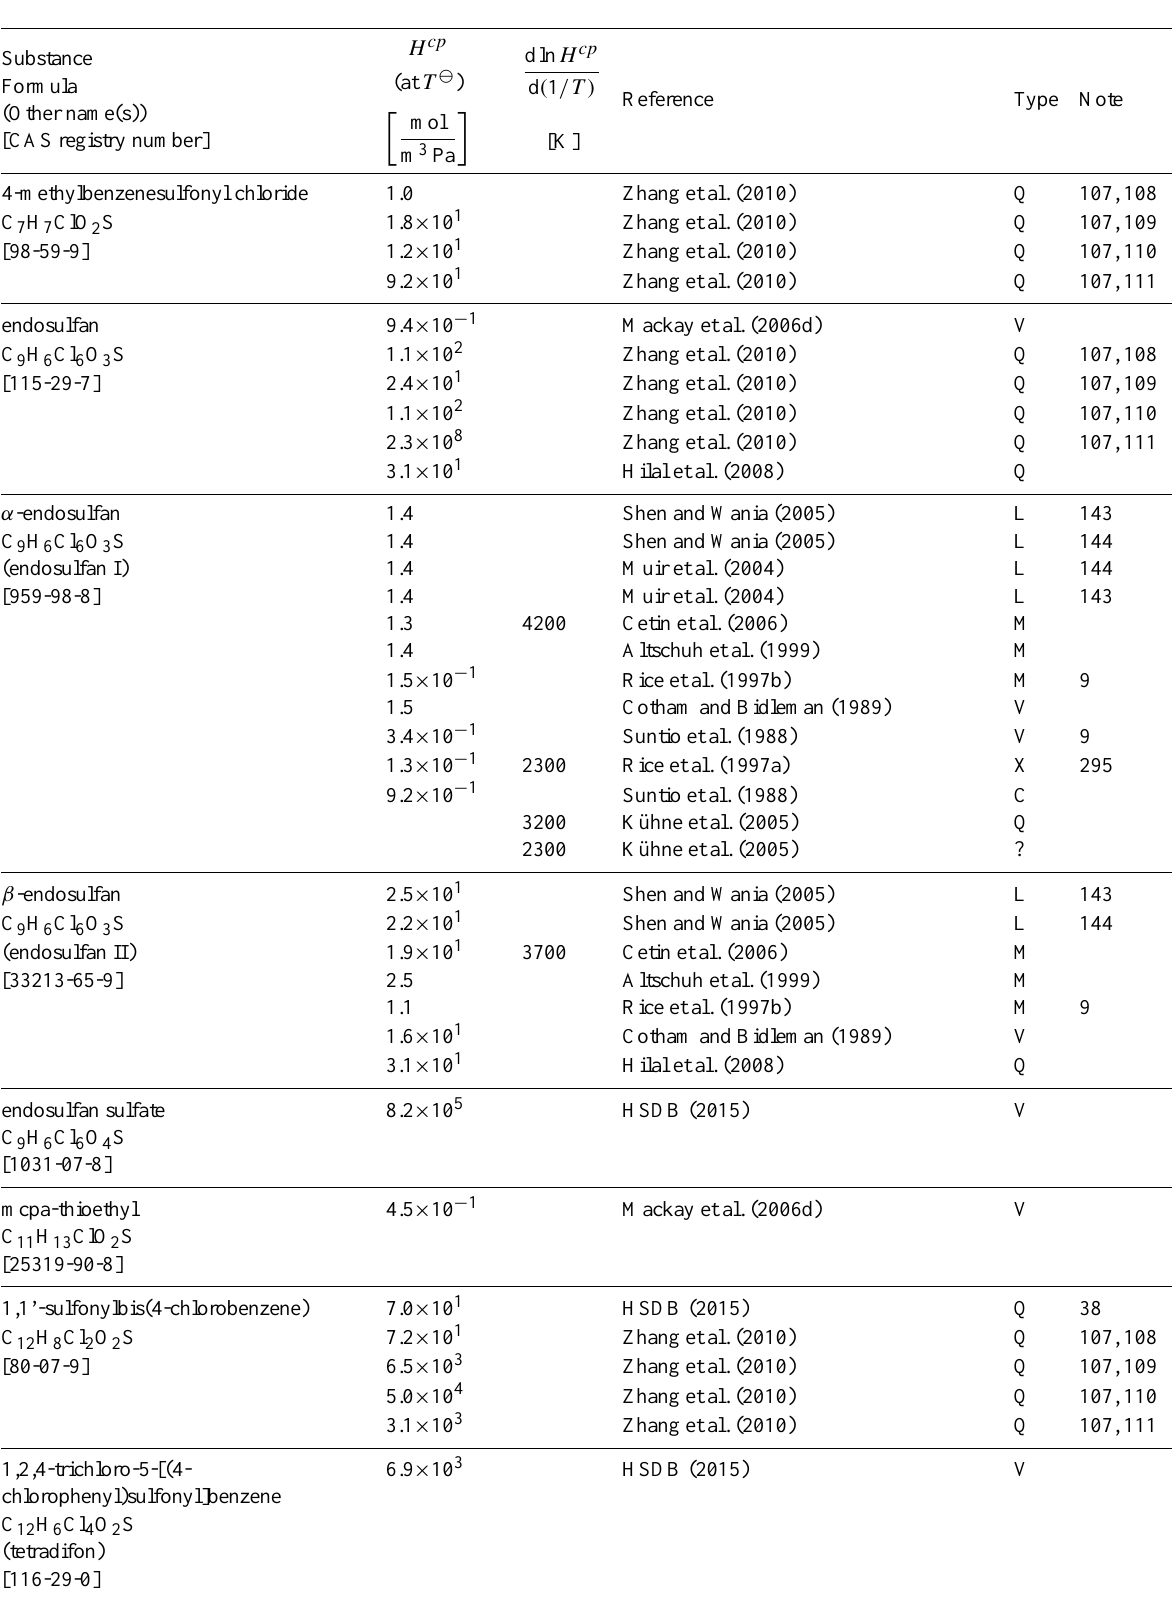
Table 6: Henry’s law constants for water as solvent